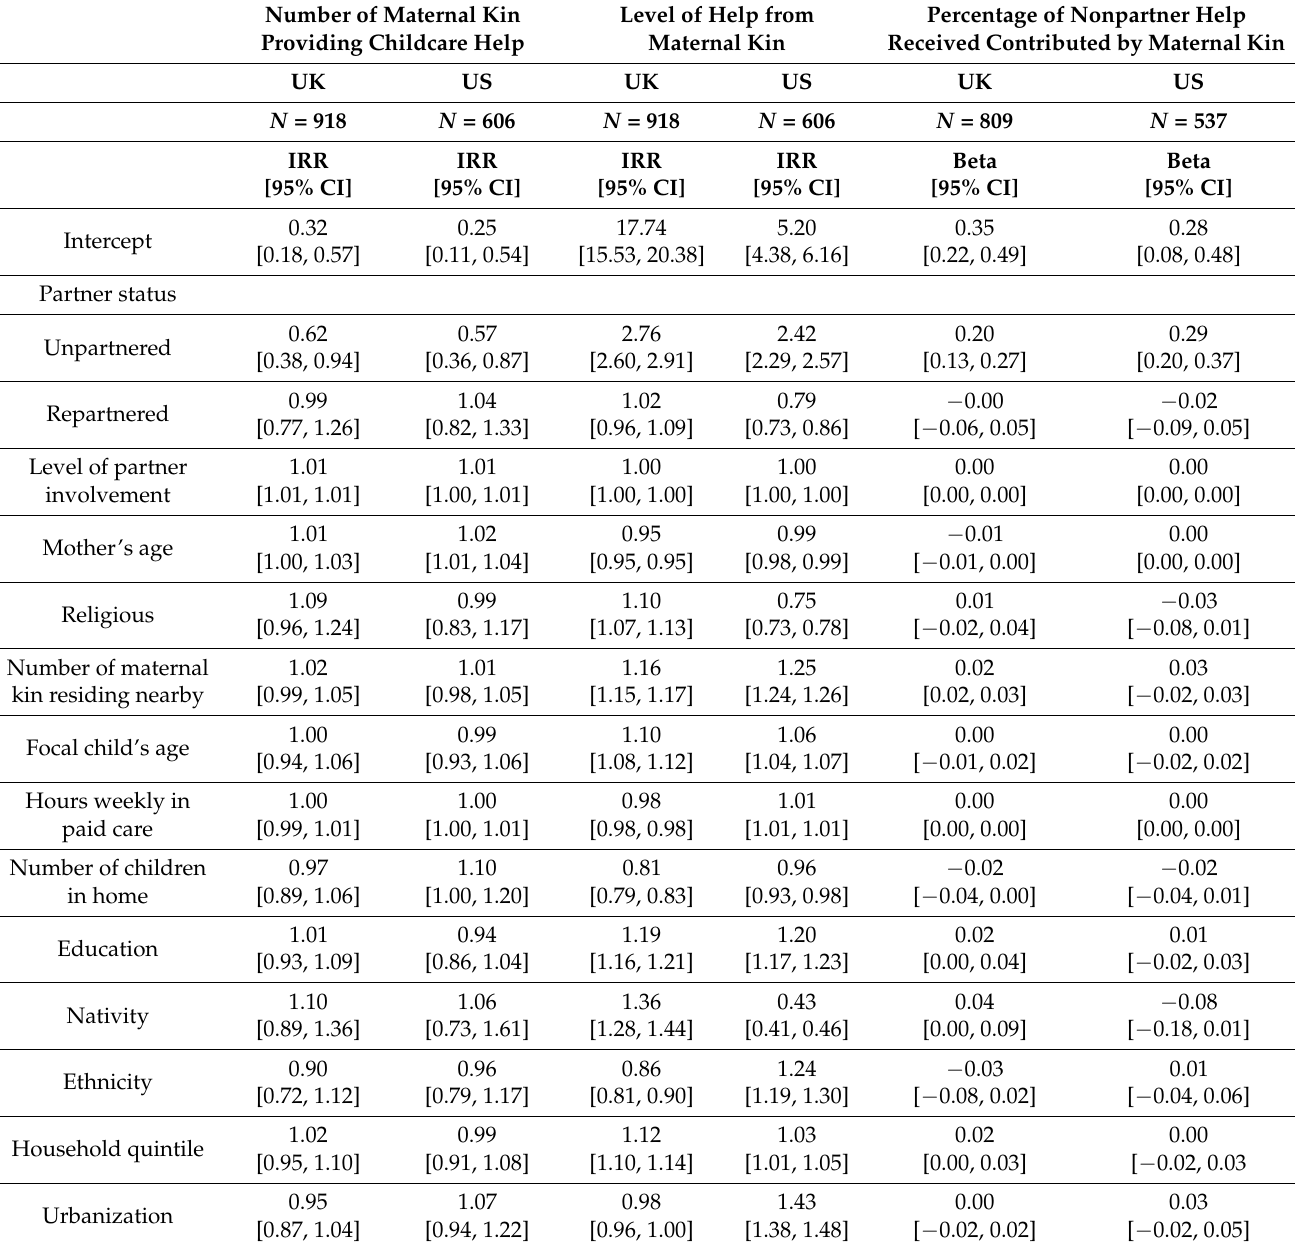
Table 3. Results of Bayesian regression models predicting childcare involvement of maternal kin in the US and in the UK. Number of Maternal Kin Level of Help from Percentage of Nonpartner Help Providing Childcare Help Maternal Kin Received Contributed by Maternal Kin